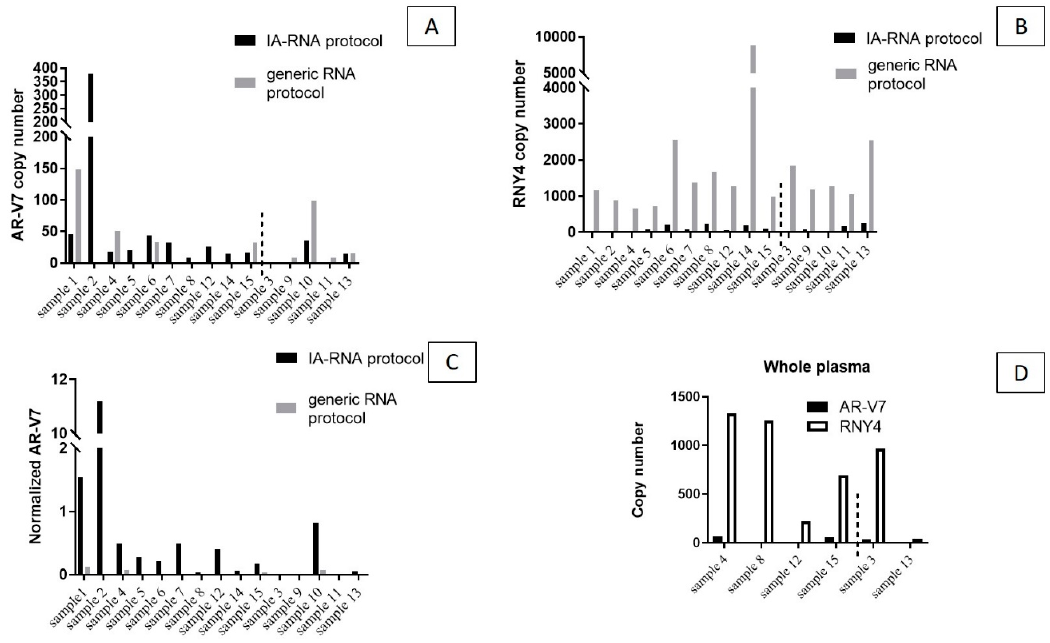
immune-a ffi nity (IA)-RNA protocol and generic RNA protocol. ( C ) Normalized AR-V7 copies / Figure 1. ( A ) Androgen receptor ( AR) -V7 and ( B ) RNY4 copies/mL (respectively) detected with immune-affinity (IA)-RNA protocol and generic RNA protocol. ( C ) Normalized AR-V7 copies/mL.